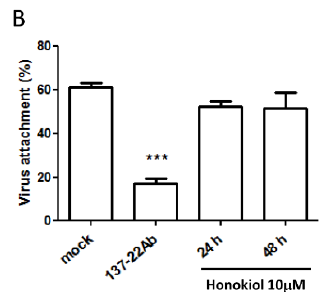
Figure 4. Pre-treatment of honokiol does not affect DENV receptor expression in cells. ( A ) BHK cells were treated with honokiol at 10 μM concentration for 24 or 48 h and then incubated with dengue virus for 30 min to process the virus attachment. Simultaneously treatment of neutralizing antibodies 137-22 upon infection was used as a control group to block the specific DENV binding. Unbound virus was washed away with PBS and the cells were labeled with anti-DENV E protein antibody and secondary antibody for flow cytomerty analysis; ( B ) The percentage of cells showing positive fluorescent signals was plotted. Data indicate the average value of triplicates (mean ± SD). *** p < 0.001 as compared with the control.